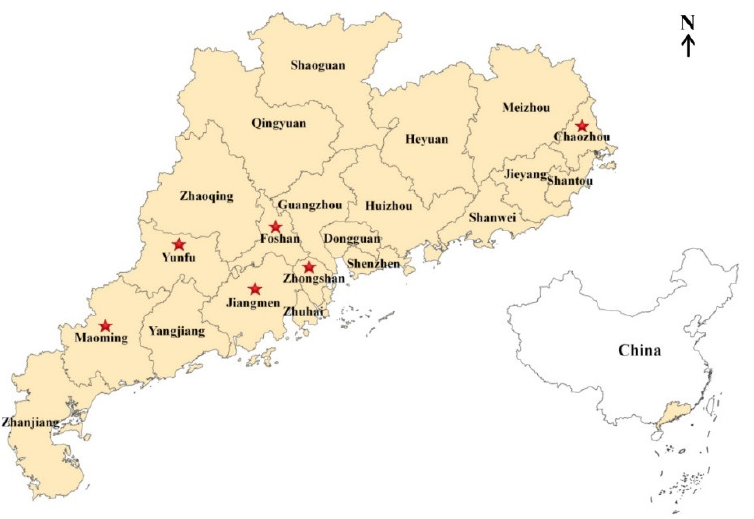
Figure 1. Collection of Asian citrus psyllid within Guangdong province. The map is taken from Li et al. [25] with minor modifications. Red stars represent the city sampling areas.